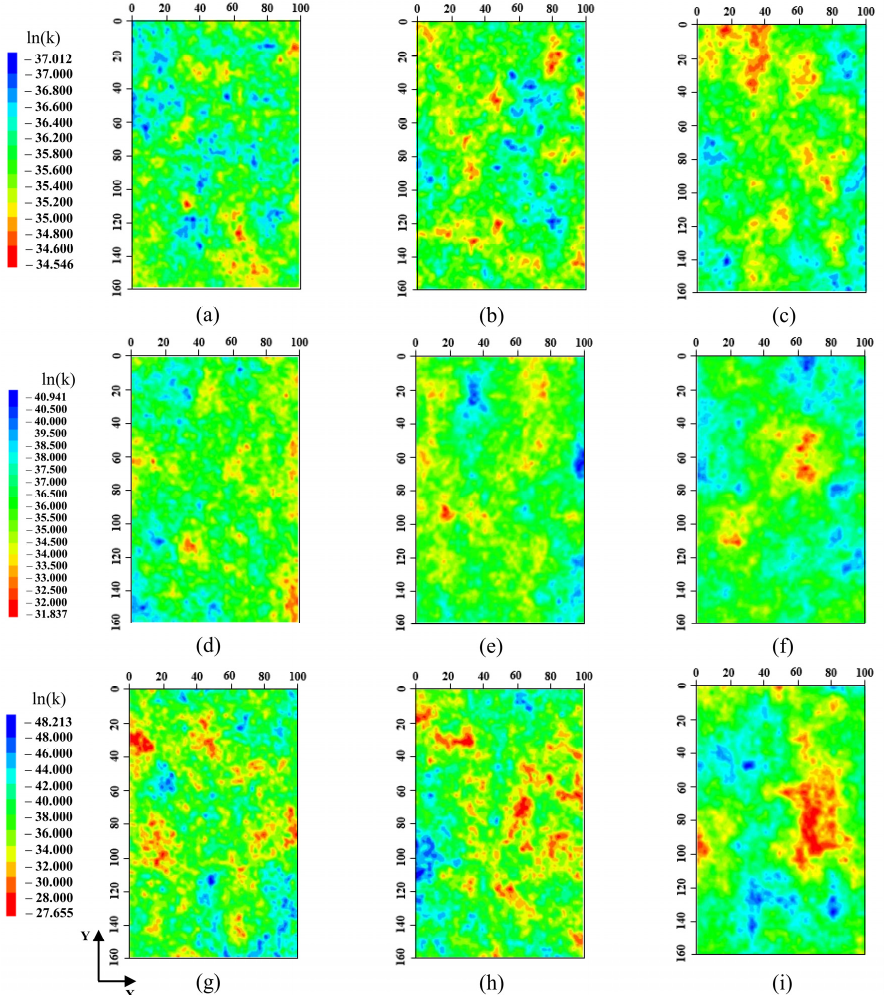
Figure 5. Generated permeability distribution field ( a ) SD = 0.025 (-), CL = 12.5 m; ( b ) SD = 0.025 (-), CL = 25 m; ( c ) SD = 0.025 (-), CL = 50 m; ( d ) SD = 0.05 (-), CL = 12.5 m; ( e ) SD = 0.05 (-), CL = 25 m; ( f ) SD = 0.05 (-), CL = 50 m; ( g ) SD = 0.1 (-), CL = 12.5 m; ( h ) SD = 0.1 (-), CL = 25 m; ( i ) SD = 0.1 (-), CL = 50 m.